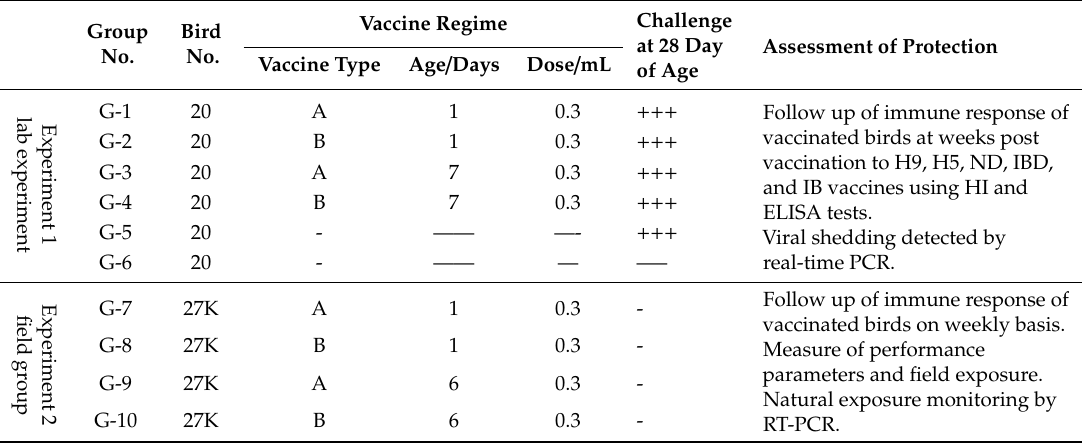
Table 1. Experimental design for di ff erent groups